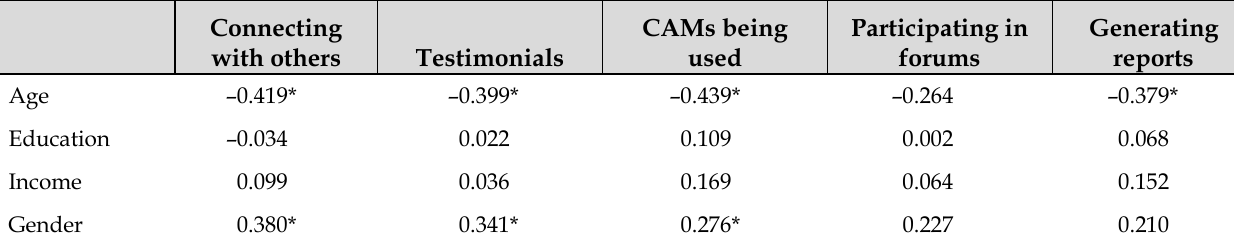
Table 5 Spearman correlations between demographics and interest in portal functionality (n=55)